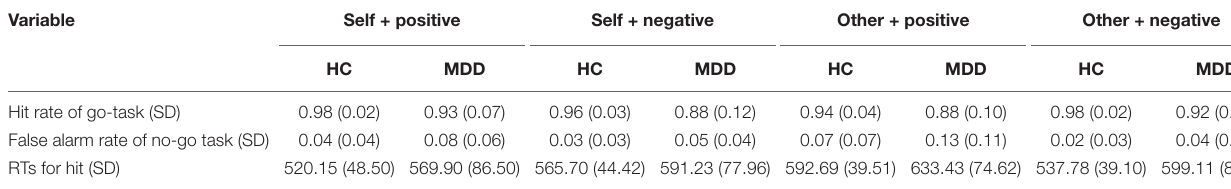
TABLE 2 | Behavior data of two groups in the self-esteem GNAT. Variable